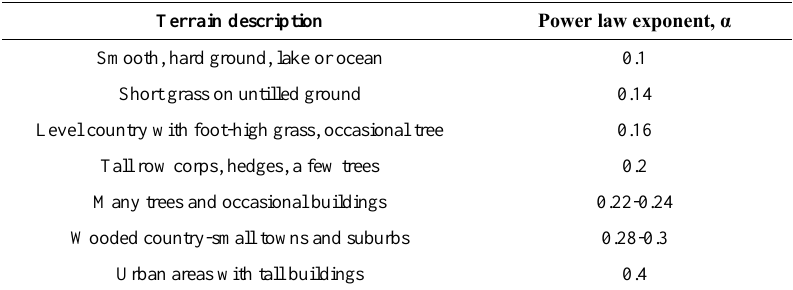
Table 1. The power law exponent α values according to the terrain description